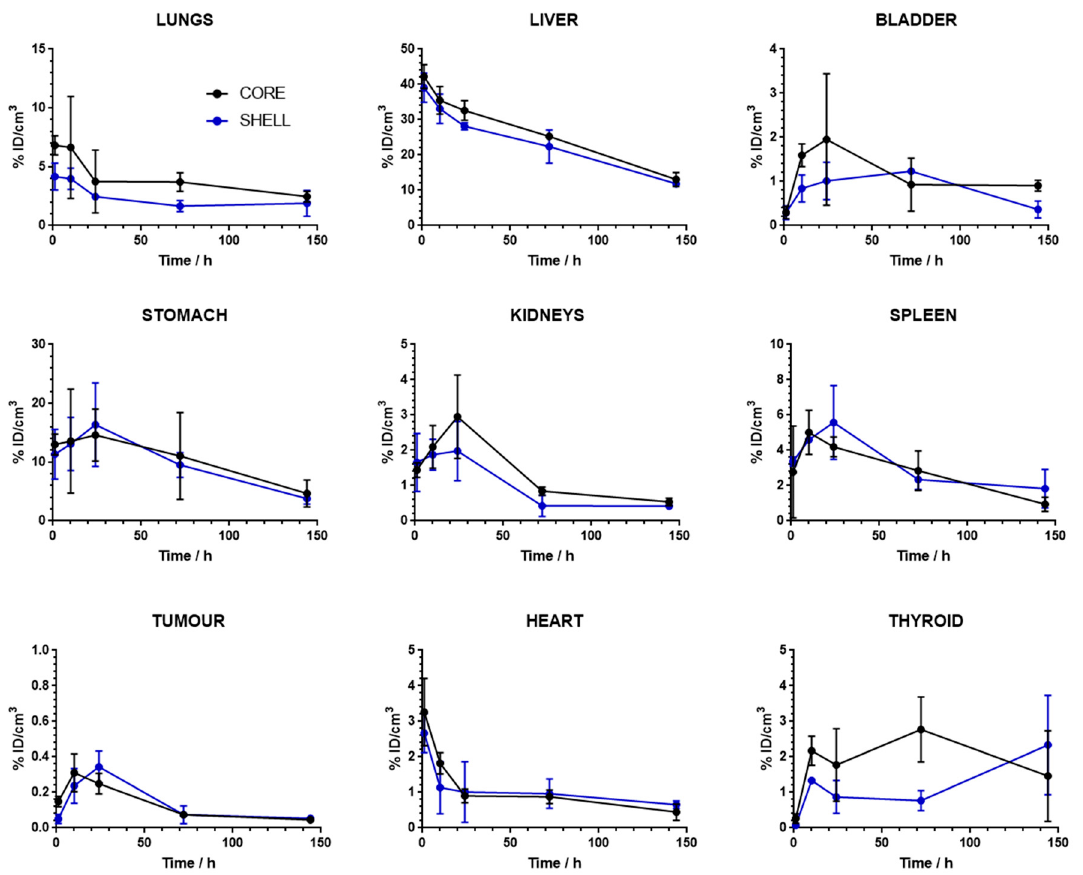
Figure 6. Concentration of radioactivity in the different organs as determined from PET images using the two radiolabelling approaches. Values are expressed as %ID/cm 3 . Values correspond to mean ± standard deviation, n = 2 per labelling strategy and time point.